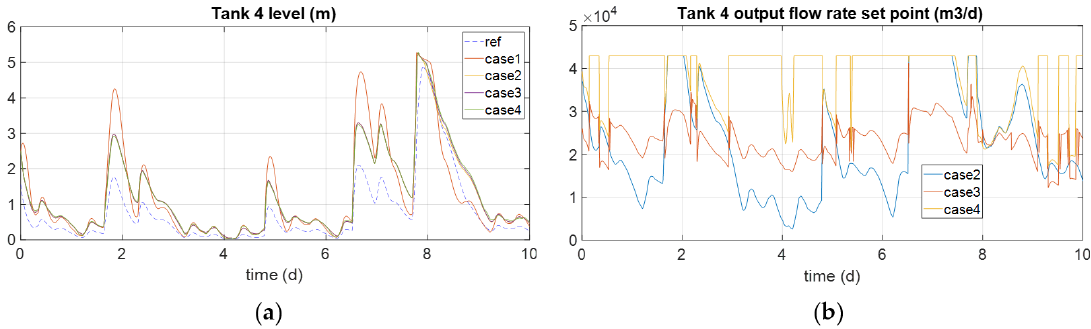
Figure 13. Tank 4 level ( a ) and output flow rate set point ( b ).